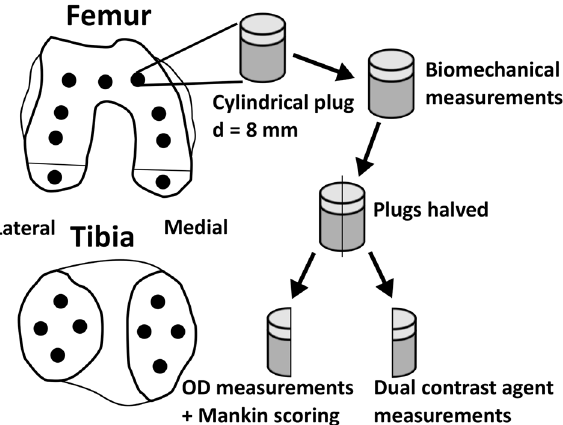
Figure 1. Osteochondral plugs ( n = 57, d = 8 mm) were extracted from two human cadavers (aged 68 and 79 years). Four samples were excluded from the original sample pool due to missing cartilage, leaving 53 samples for the final analysis. First, the biomechanical properties were determined. Then the plugs were halved, and one half was used for optical density (OD) measurements and Mankin score grading. The other half was used for dual contrast agent